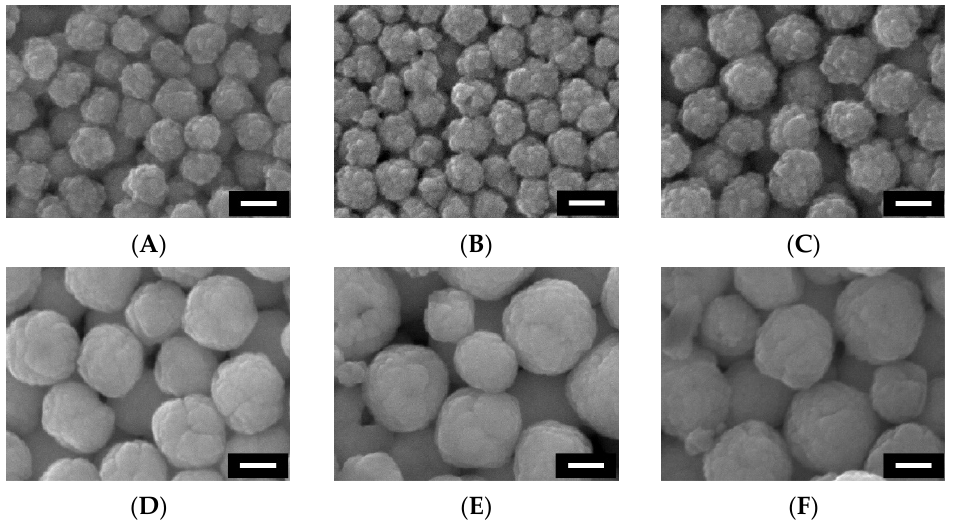
Figure 2. ( A – F ) SEM images of a series of magnetite microparticles of M-1 – M-6 . All white scale bars represent 100 nm.